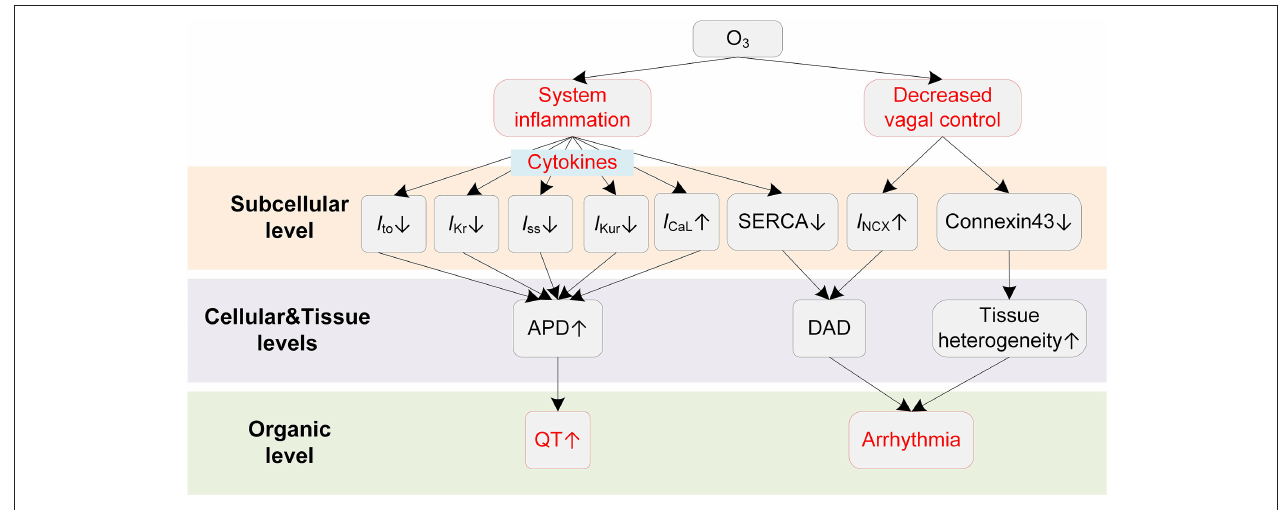
FIGURE 6 | Potential mechanisms underlying O 3 -induced arrhythmias. Red boxes indicate effects of O 3 that have been explicitly